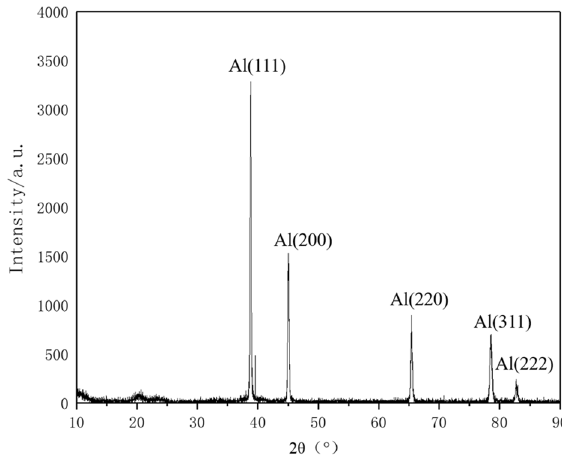
Figure 3. The X-ray diffraction of the sintered